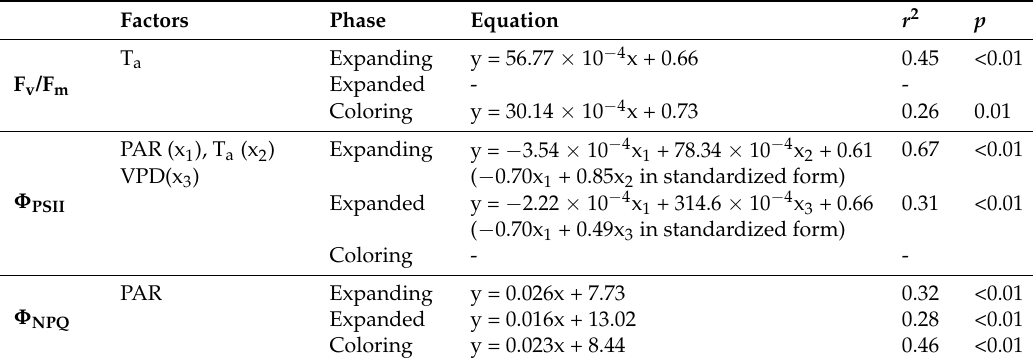
Table 2. Multi-variate linear regressions between meteorological variables and ChlF-associated parameters during the growing season (DOY 102 to 285) of 2014. Independent variables include daily mean incident photosynthetically active radiation (PAR), air temperature (T a ), relative humidity (RH), and atmospheric vapor pressure deficit (VPD). Dependent variables include maximal quantum yield of PSII photochemistry (F v /F m ), daily mean effective quantum yield of PSII photochemistry ( Φ PSII ), and quantum yield of regulatory light-induced non-photochemical quenching ( Φ NPQ ). p -values represent significant level for the regression models. r 2 is the coefficient of determination.